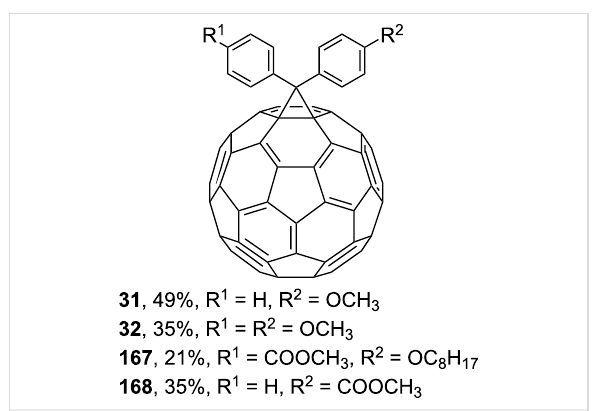
Figure 11: 4,4-Diphenylfullerene derivatives 31 , 32 , 167 , and 168